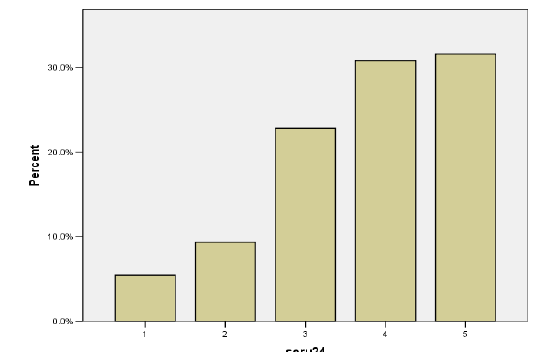
Figure 14. Should students be trained in a specific way which will make them very familiar with professional accounting and auditing standards?